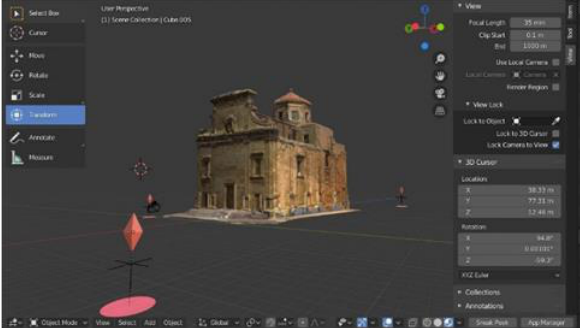
Figure 10. Positioning of the points to view relatively to the WEB navigation model.